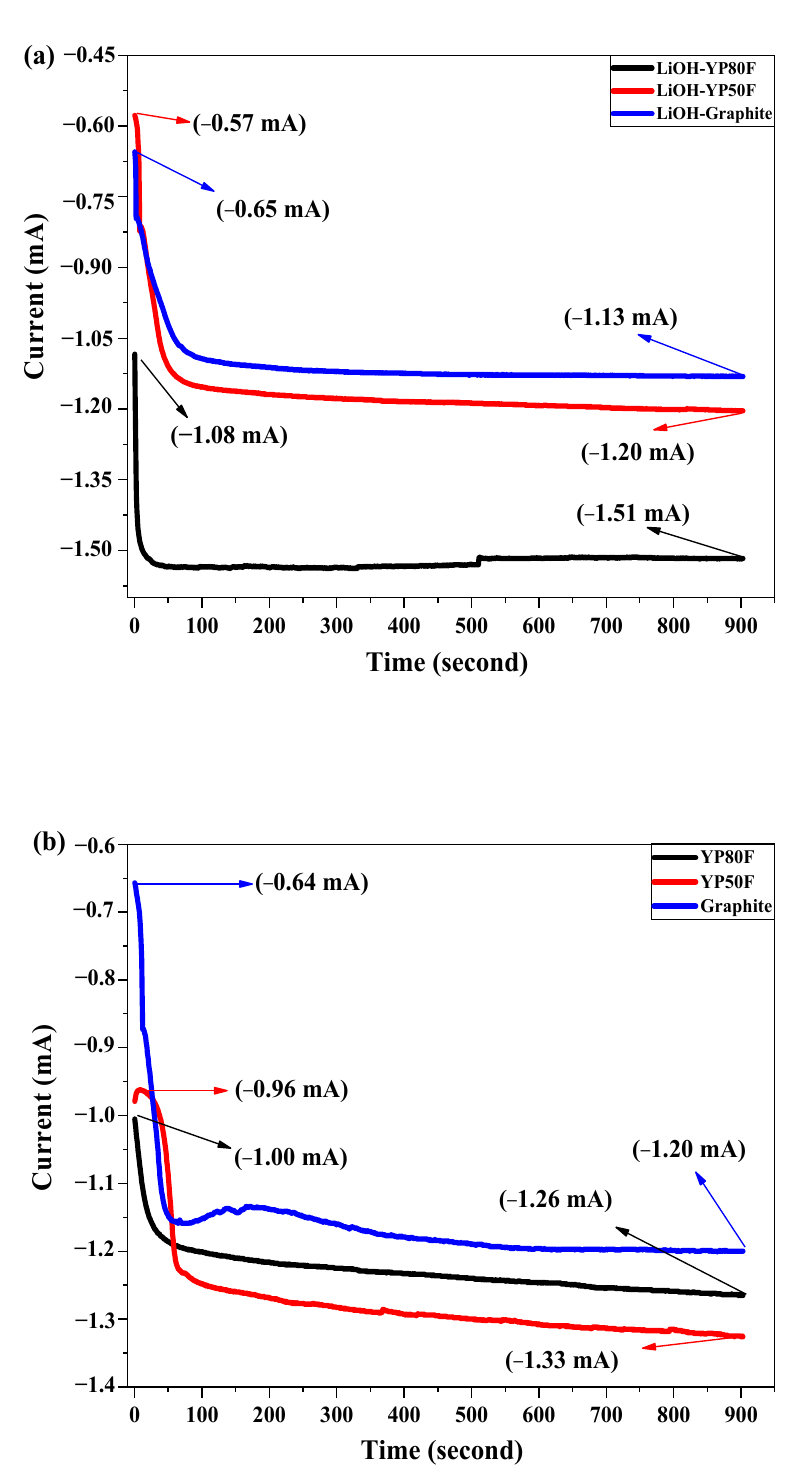
Figure 12. Chronoamperometry test of LiOH-treated YP80F, YP50F and Graphite (Cu-current col- lector and 5% KOH electrolyte). ( a ) LiOH-treated samples; ( b ) pure samples.